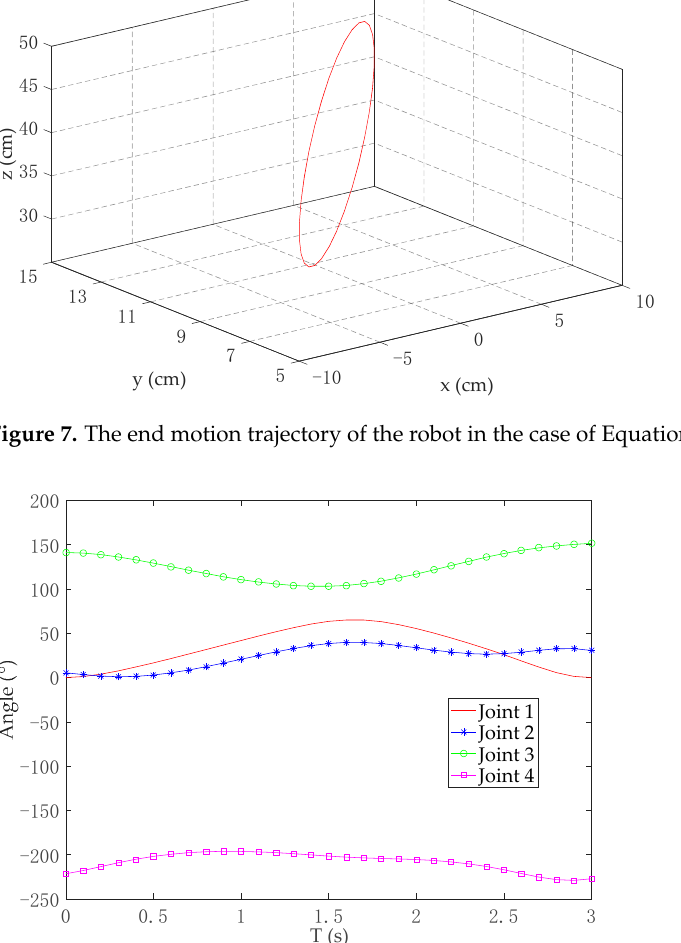
Figure 8. The trajectory of the joint angle in the case of Equation (43). When the motion equation is Equation (44), the motion trajectory in space and the change curves of four joint angles are shown in Figures 9 and 10, respectively.